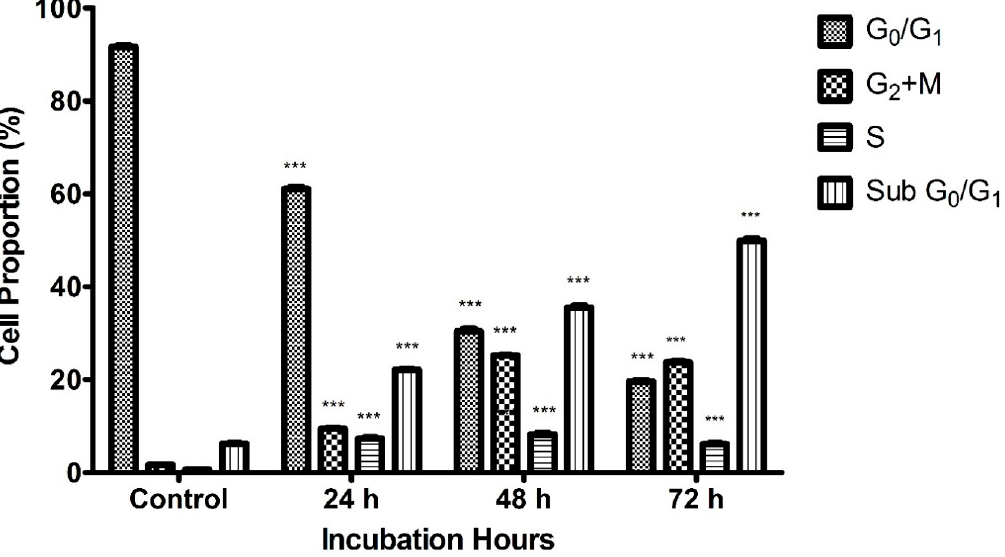
Figure 9. Time-dependent distribution of the raphasatin-treated MCF-7 cells for the different cell cycle stages. Cells were treated with 9.84 µ M (IC 50 ) concentration of raphasatin for 24, 48, and 72 h. The data comparing the proportion of cells between the untreated with the treated, in terms of cell cycle for 24, 48, and 72 h of incubation. The data expressed as mean ± SD. *** p < 0.001.